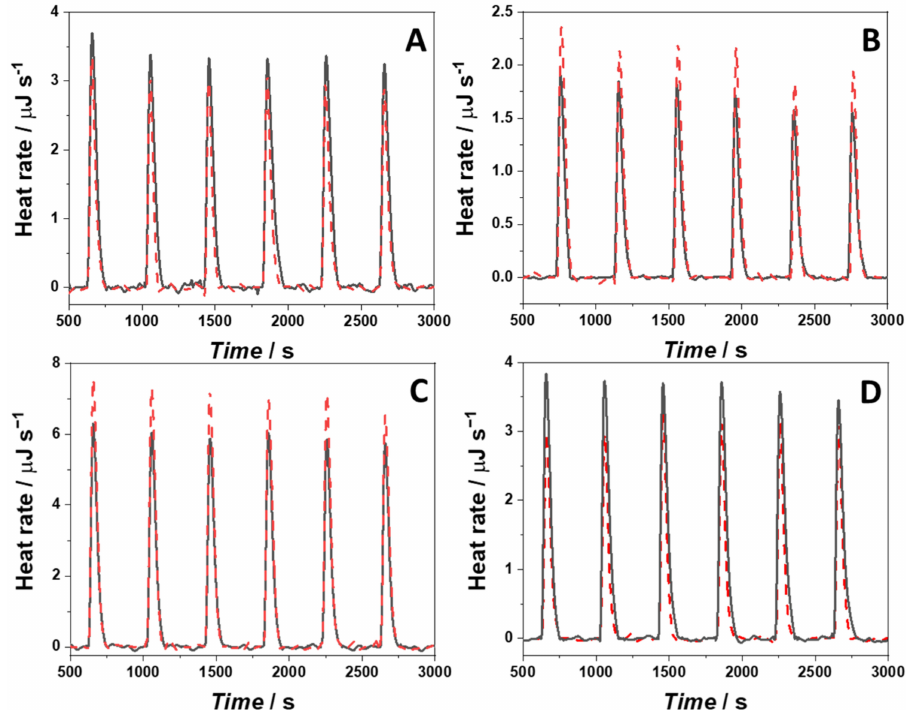
Figure 5. ITC traces (black lines) obtained from the titration of a solution of ( A ) 22AG in the presence of 100 mM NaCl, ( B ) 22AG in the presence of 100 mM KCl, ( C ) RG-1 in the presence of 100 mM NaCl, and ( D ) RG-1 in the presence of 100 mM KCl, with a solution of berberine. The red dashed lines represent the heat peaks obtained from the G4Q dilutions in the respective buffers. All the experiments were carried out in 30 mM Tris-HCl buffer, pH 7.4, at the temperature of 25 ◦ C. The binding enthalpy for complex formation between berberine and 22AG in the presence of 100 mM NaCl was found to be negative, ∆ H ◦ b = − 15.5 kJ mol − 1 , i.e., the binding is an exothermic process. The entropic contribution to binding, T ∆ S ◦ b , is positive (10.5 kJ mol − 1 ), i.e., is favorable for binding as well. Surprisingly, for the same system in the presence of 100 mM KCl, ∆ H ◦ b is positive (19.5 kJ mol − 1 ). With a positive T ∆ S ◦ b of 52.4 kJ mol − 1